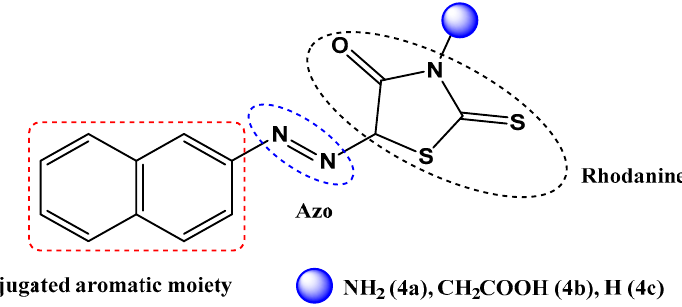
Figure 1. Template design for 5-arylazorhodanine 4a–c .